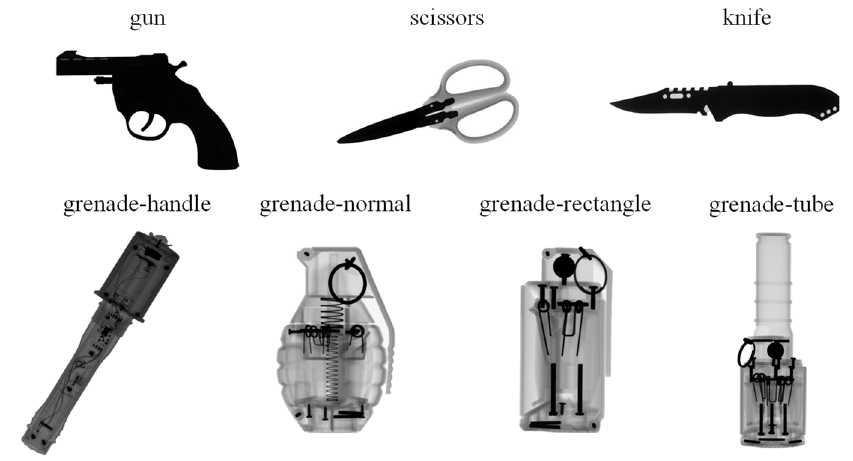
Figure 9. Examples of target dangerous goods.